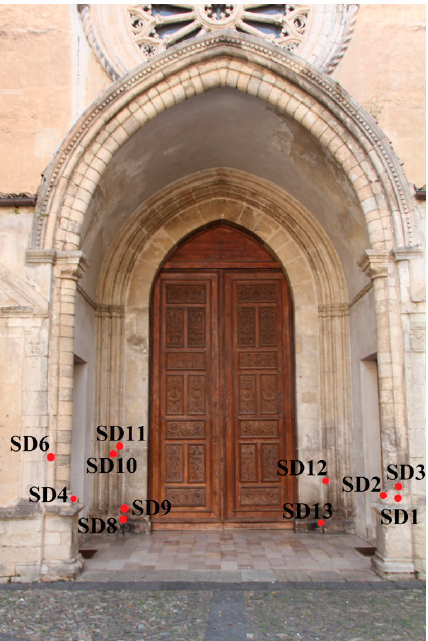
Figure 2. Portal of San Domenico Church (Cosenza, Italy) and details of the sampled areas.